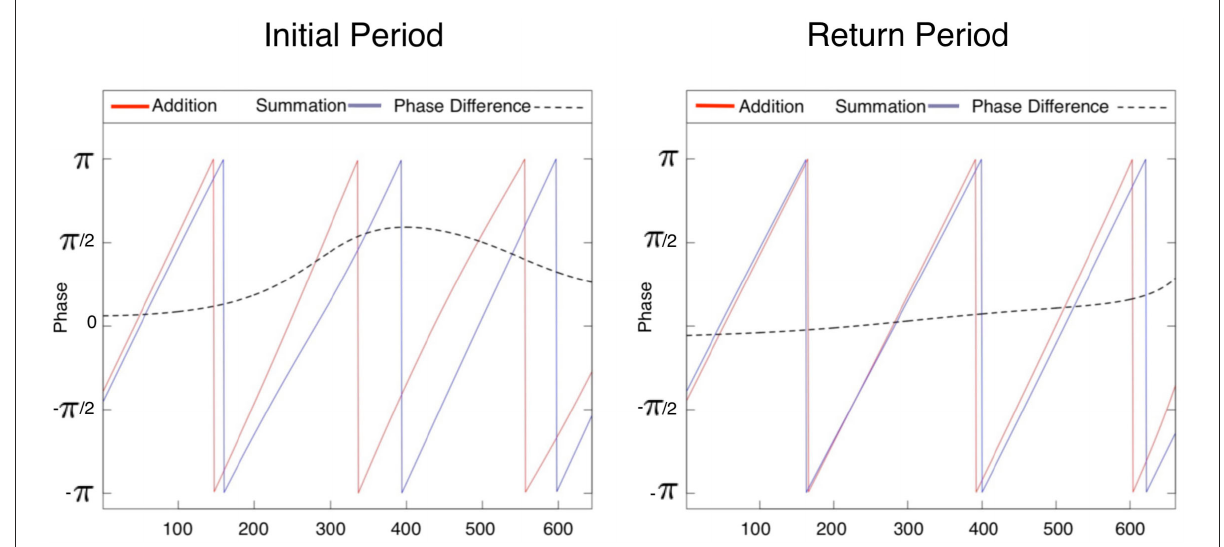
FIGURE6 Within study period phase of the two tasks computed in the first 600 data points in the time series. Whereas a higher phase difference [mean(min, max)] in the initial study period 0.3336 π (0.0612 π , 0.5927 π ) indicates a that the series are non-synchronized initially, in the return study period the reduction of the phase difference to 0.0507 π (-0.0561 π , 0.2873 π ) suggests that displacements of periodic phenomena in two time series are minimally different. This likely indicates similar learning rates for both tasks in the latter study